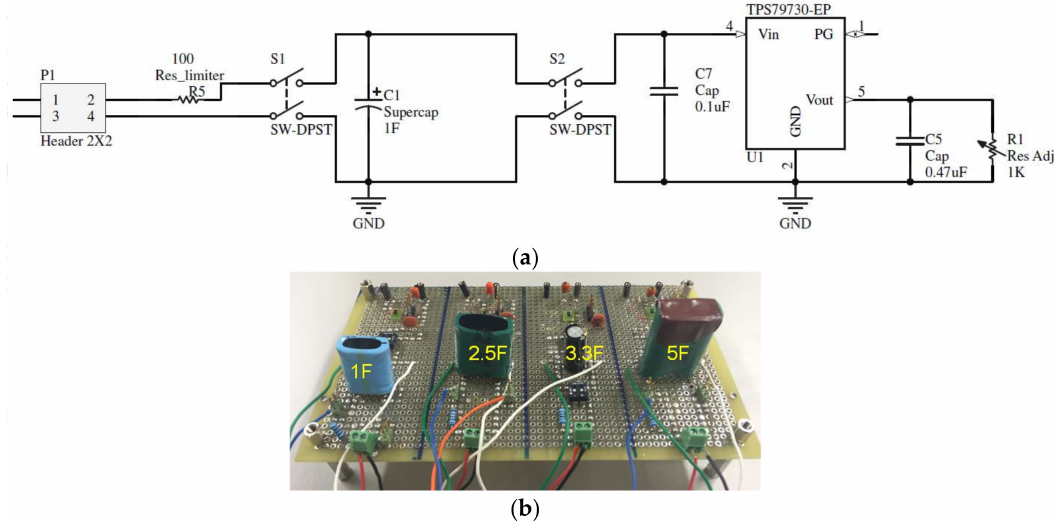
Figure 3. Evaluation board set-up. ( a ) Schematic of a single capacitor test fixture. ( b ) Complete test evaluation